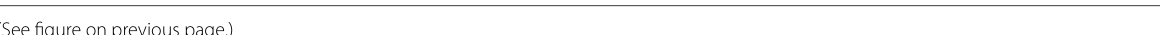
figure on previous page.) Fig. 2 Wavelet power spectra of a , b the DW1 amplitude averaged within 10 ° S–10 ° N, c , d the DE3 amplitude averaged within 0 ° –20 ° N, e, f the DE3 amplitude averaged within 0°–20°S, and g ONI. The division of DE3 into the two latitudinal regions is due to its equatorial asymmetry natural. The powers are shown on the log2 scale. Black dots indicate the QBO period as a function of time. The QBO period is defined as the location of maximum values, the period ranging from 1.5 to 3.5 years. Black curves indicate the cone of influence zone of the wavelet